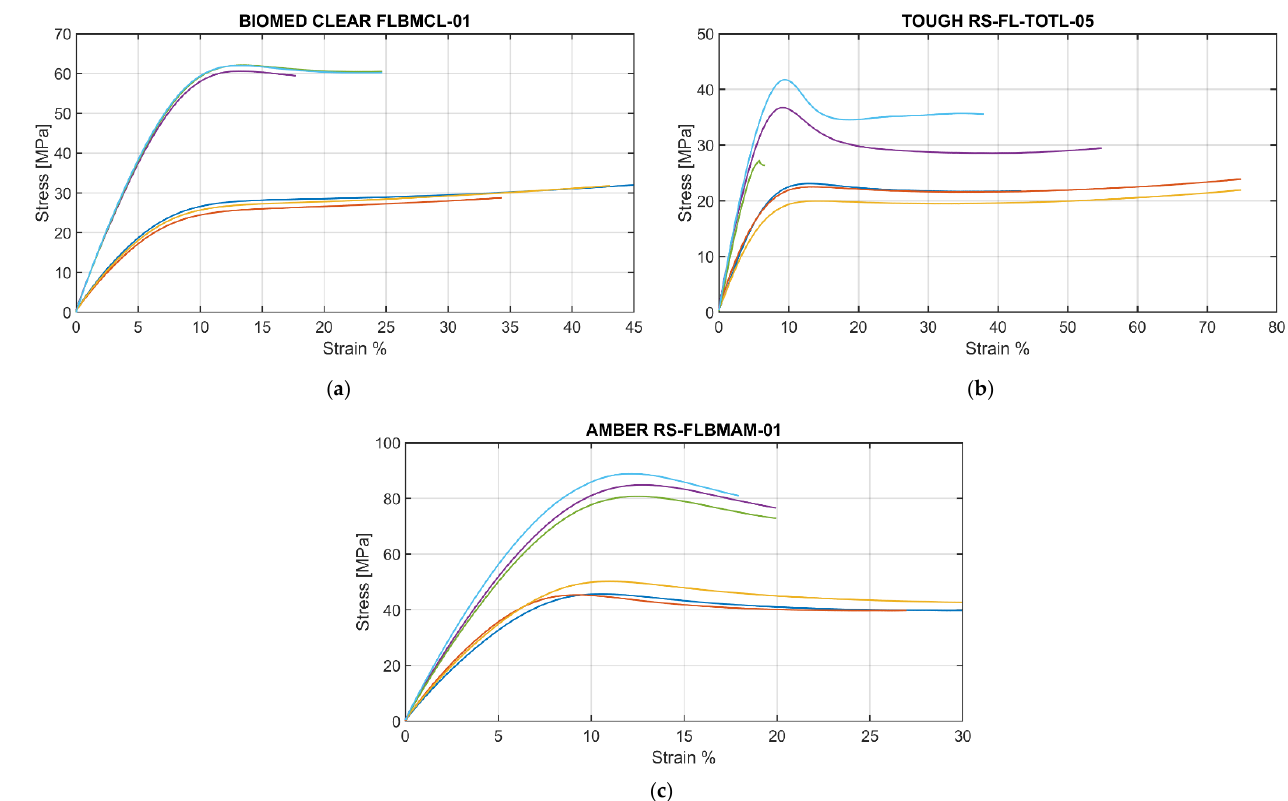
Figure 3. Stress-strain curve green and post-cure of BioMed Clear ( a ), Tough ( b ), and BioMed Amber ( c ) Resins. Lines are coloured as in Figure 2.